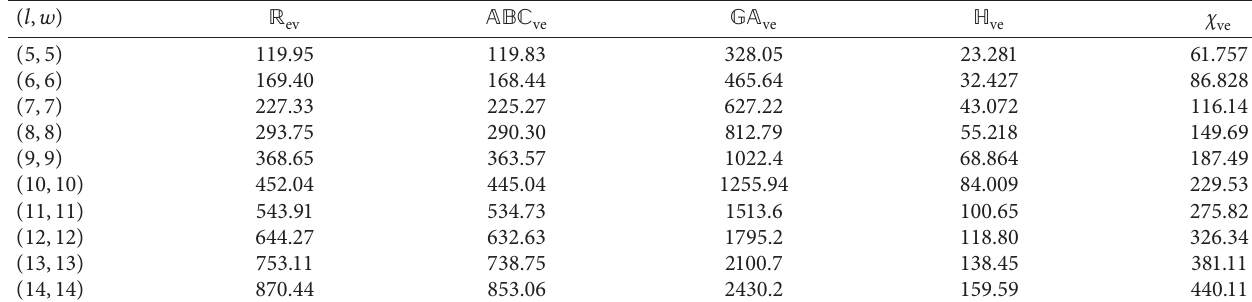
Table 5: Numerical representation of results.